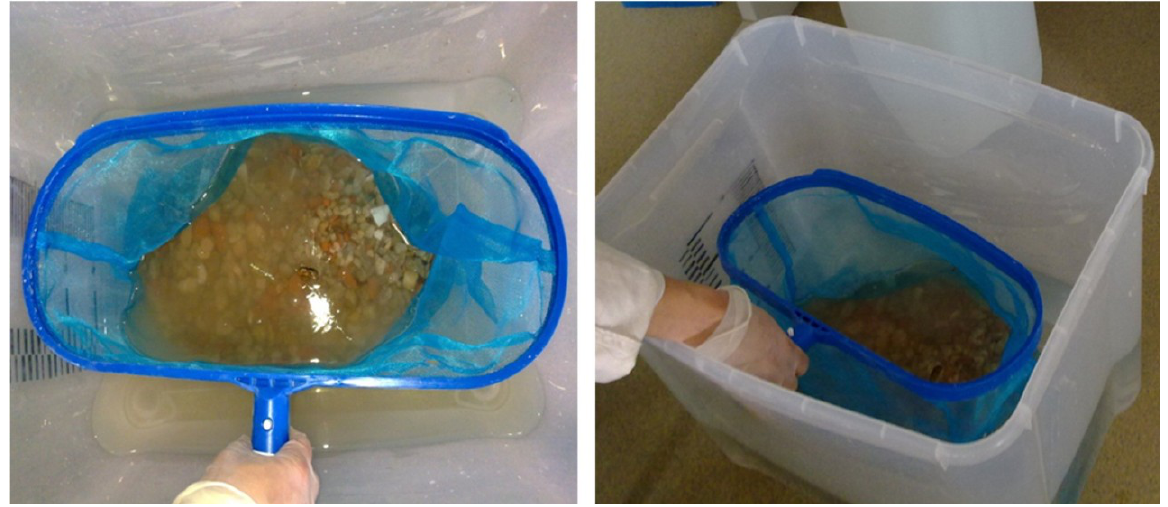
Figure 2. Pre-saturation of recycled aggregate prior to the addition in the concrete